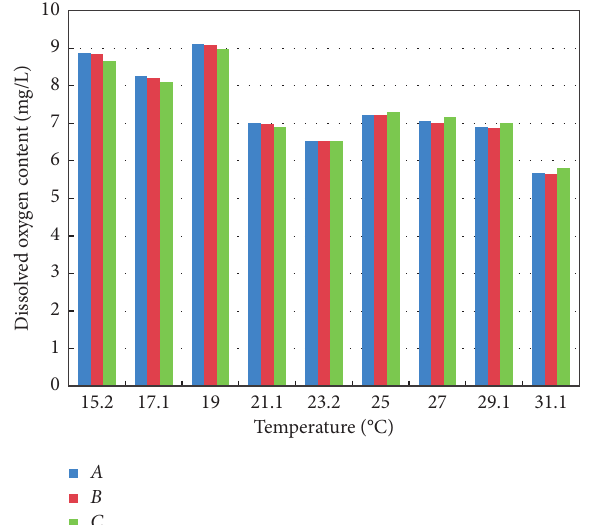
Figure 9: Measurement results of old and new temperature compensation probes.